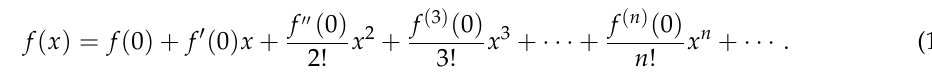
Figure 14. Evolution of the measured solar irradiance and air temperature during the data collection period with an hourly time scale.